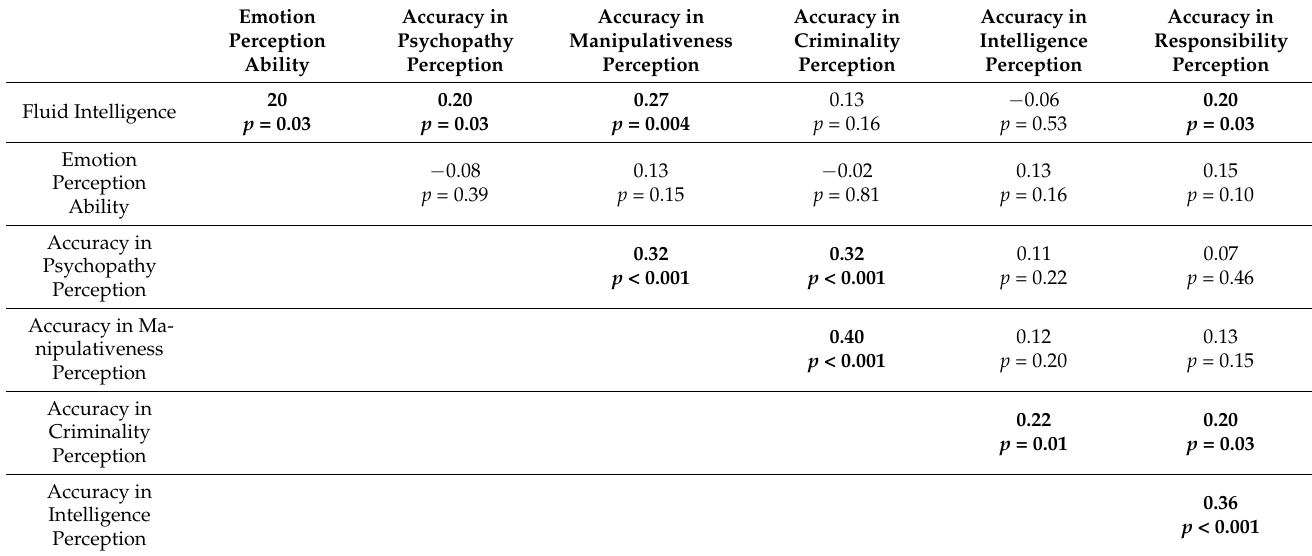
Table 5. Study 2: Manifest Correlations between cognitive abilities and trait perception